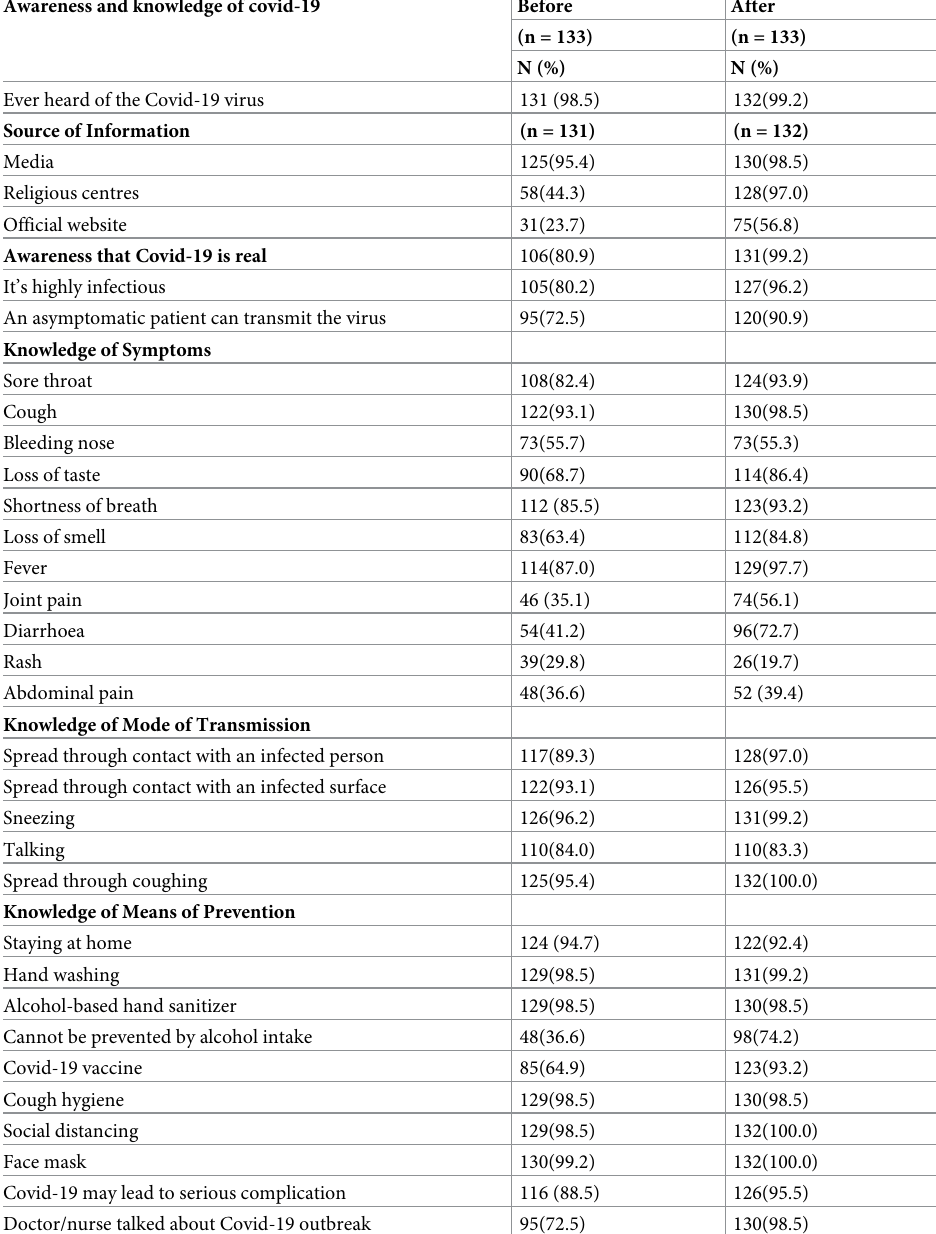
Table 7. Client’s awareness and knowledge of Covid-19 before and after interaction with trained PHC workers. Awareness and knowledge of